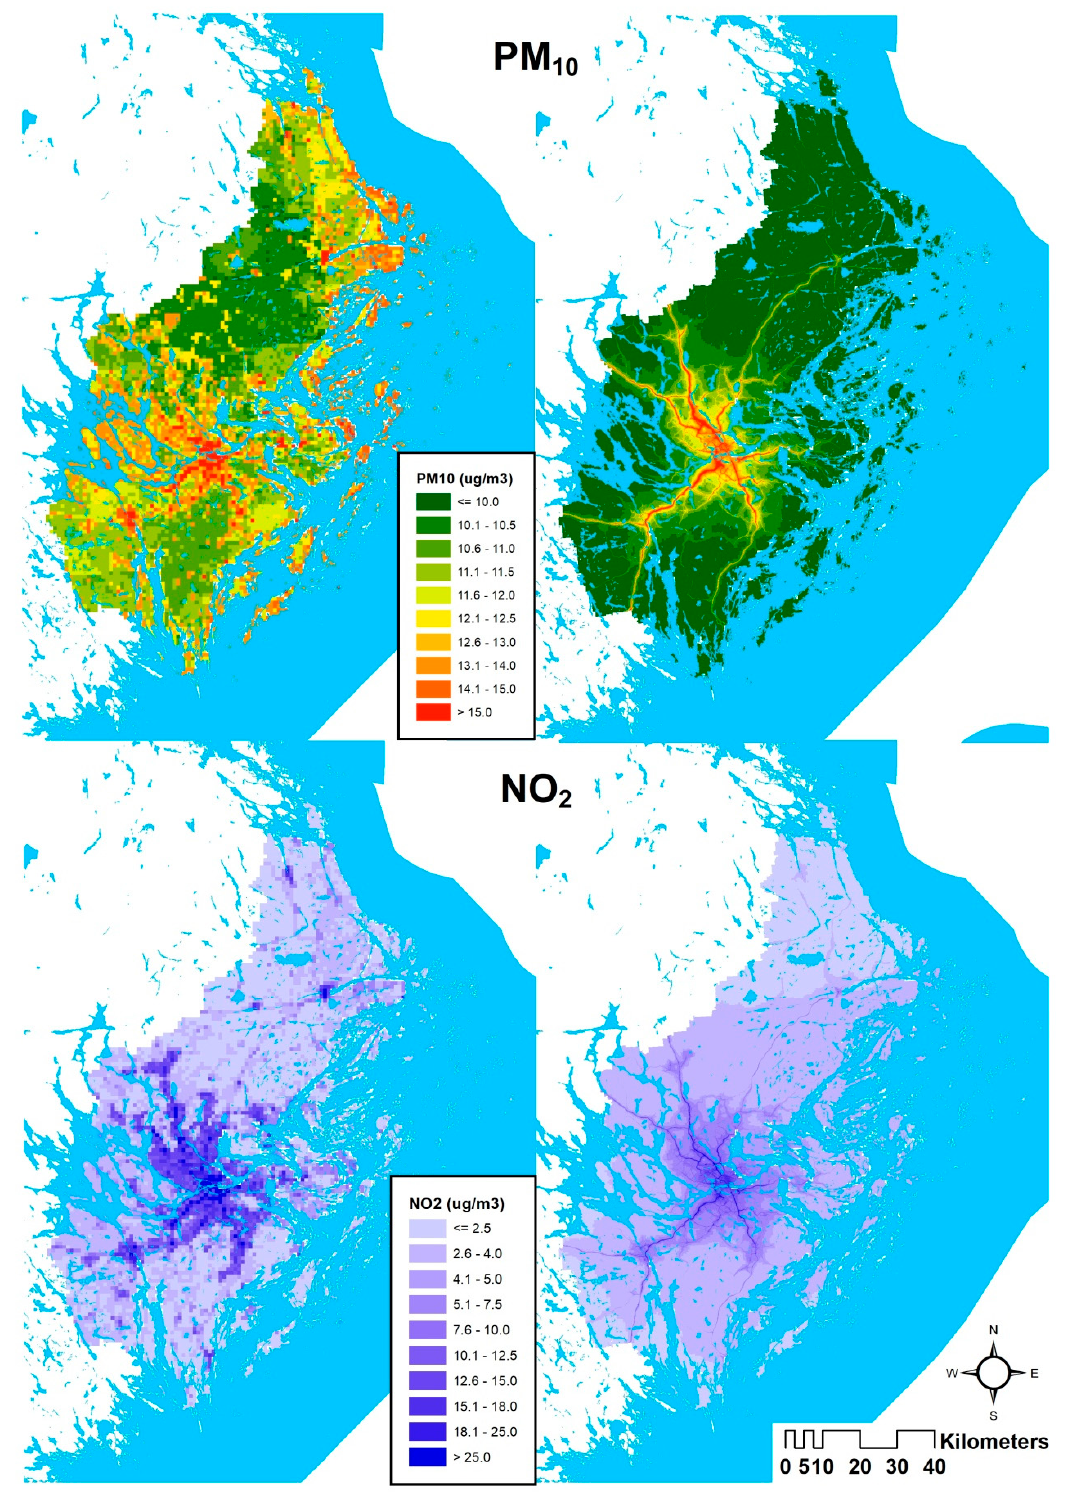
Figure 5. Prediction maps of the annual average concentrations of PM 10 ( top ) and NO 2 ( Bottom ) from random forest ( left ) and local dispersion ( right ) models in Stockholm County, year 2015.